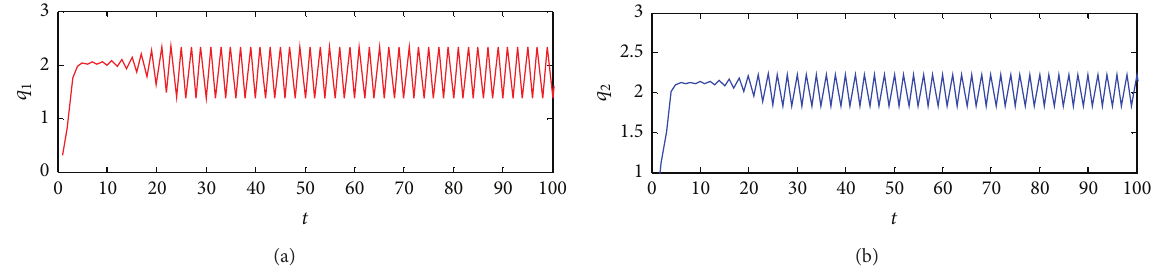
Figure 9: The 2-period status of the system as a function of time 𝑡 with the controlling factor 𝑘 = 0.3 and the parameter 𝛼 = 0.46 .